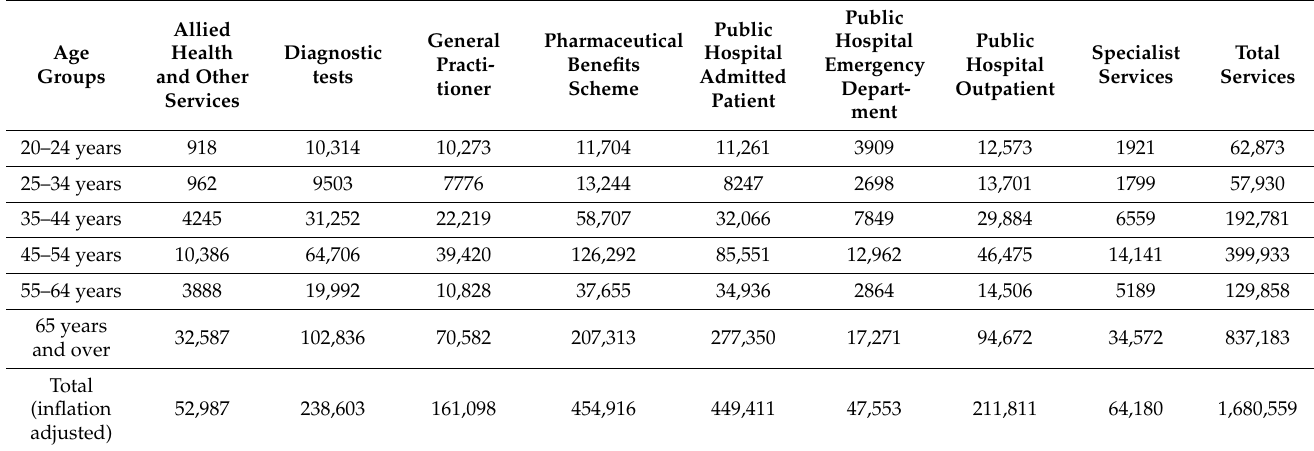
Table A9. Extra costs incurred due to LHL for people diagnosed with Musculoskeletal disorders in the Blacktown LGA (Domain 9).